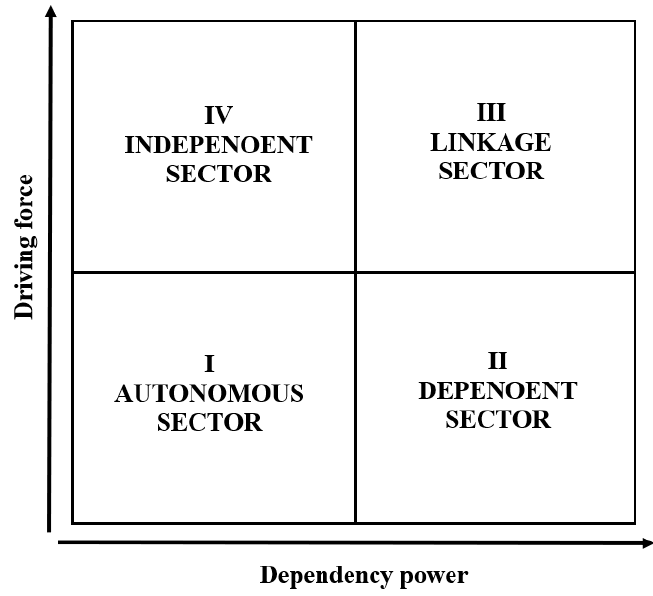
Figure 4. Matrices Impact Croises-Multiplication Appliance Classement (MICMAC).